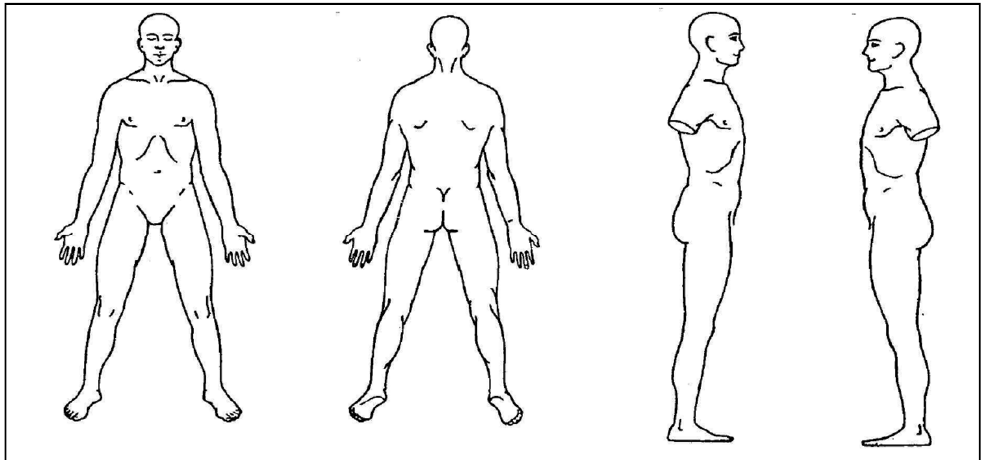
Figure 3. Mannequin sketch to mark any areas of discomfort.